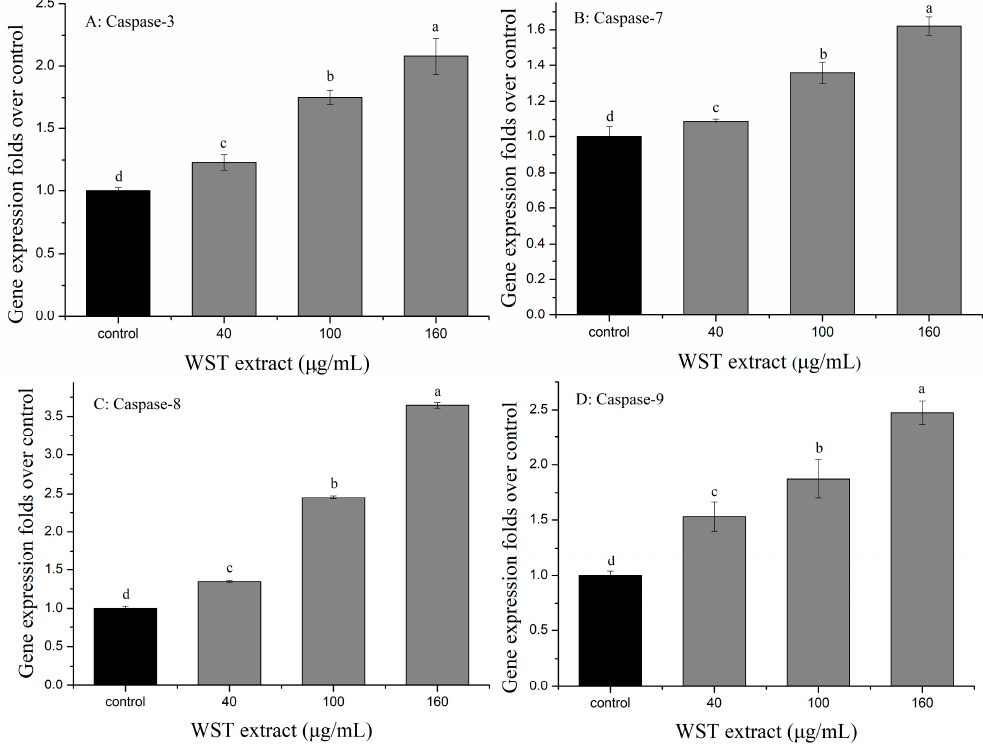
Figure 3. Effects of WST extracts on the gene expression of Capase-3 ( A ), -7 ( B ), -8 ( C ), and -9 ( D ) in human hepatoma HepG2 cells. The fold increase of Capases-3 ( A ), -7 ( B ), -8 ( C ), and -9 ( D ) mRNA expression relative to the control. The calculation formula is as follows: gene expression/GAPDH × control numerical value (control fold ratio: 1). a–d Mean values with different letters in the same bar graph are significantly different ( p < 0.05) according to Duncan’s multiple range test.